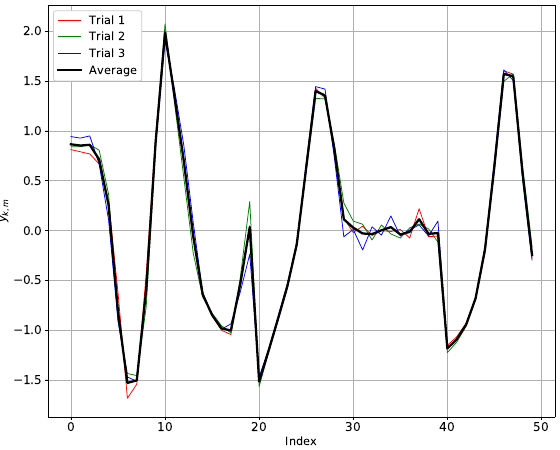
Figure 6. Average of three trials of subject S1 in the FR